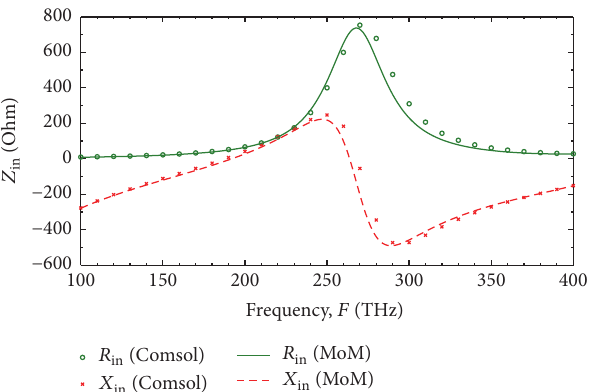
Figure 6: Input impedance of the electric nanodipole as a function of frequency.